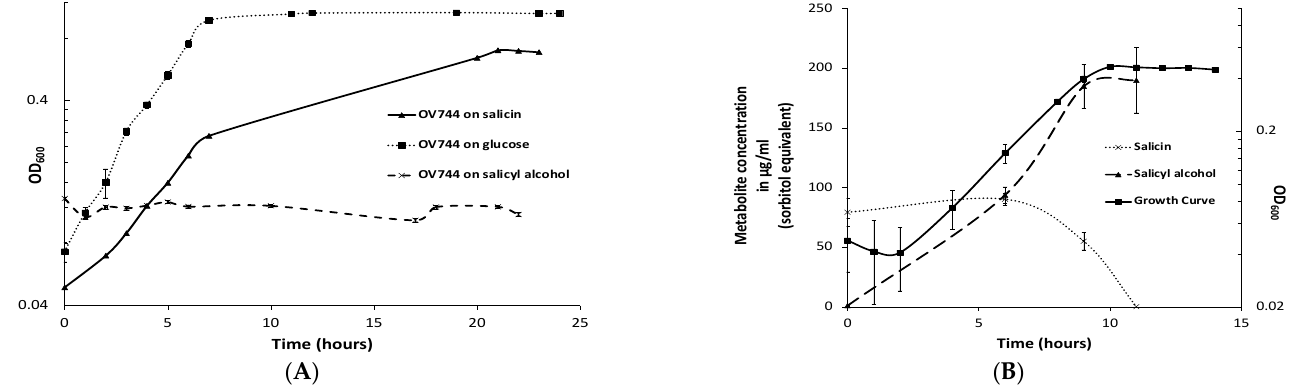
Figure 2. R. aquatilis OV744 utilizes salicin and secretes salicyl alcohol in the process. ( A ) When Rahnella was inoculated with salicin, glucose and salicyl alcohol, it was able to grow on salicin and glucose, but not on salicyl alcohol minimal medium. ( B ) A time-course metabolite analysis was performed on the supernatant of OV744 salicin culture. A reduction in the levels of salicin was clearly visible along with the rise in salicyl alcohol levels in the supernatant samples.